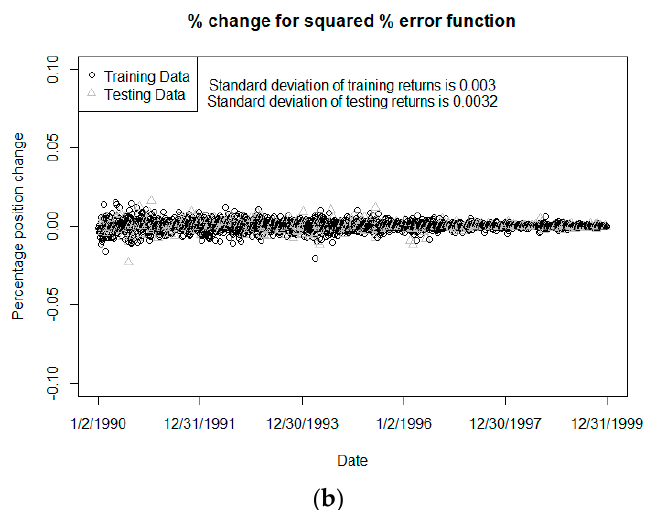
Figure 4. Results for hedging for GMDB using squared error function: ( a ) The daily position value over the 10-year life of the variable annuities (VA) contract; ( b ) the daily percentage change in the position over the life of the contract, including both training and testing.